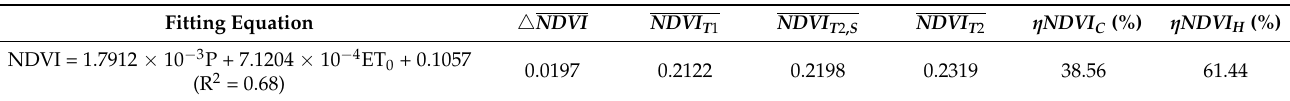
Table 3. Attribution analysis of vegetation change in the